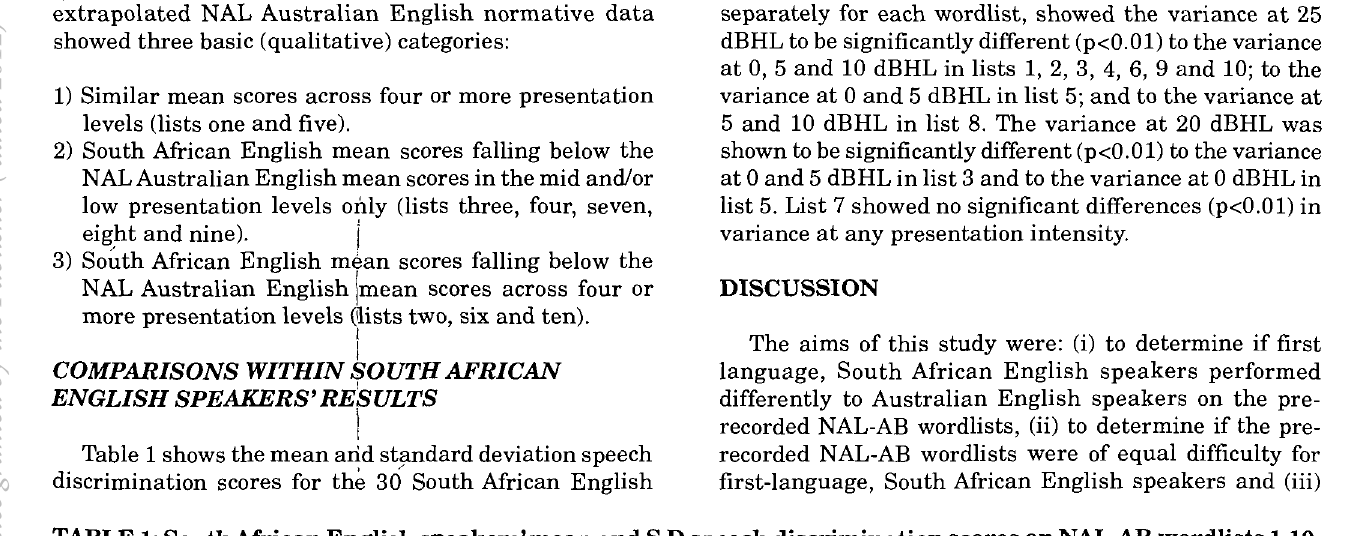
TABLE 1: South Mrican English speakers'mean and S.D speech discrimination scores on NAL·AB wordlists 1·10.